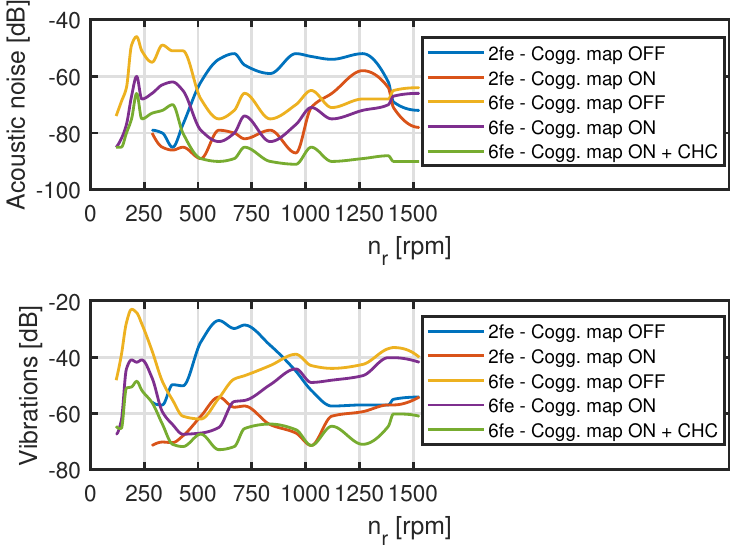
Figure 29. Acoustic noise and vibrations (2 f e curve and 6 f e curve) vs. mechanical speed n r